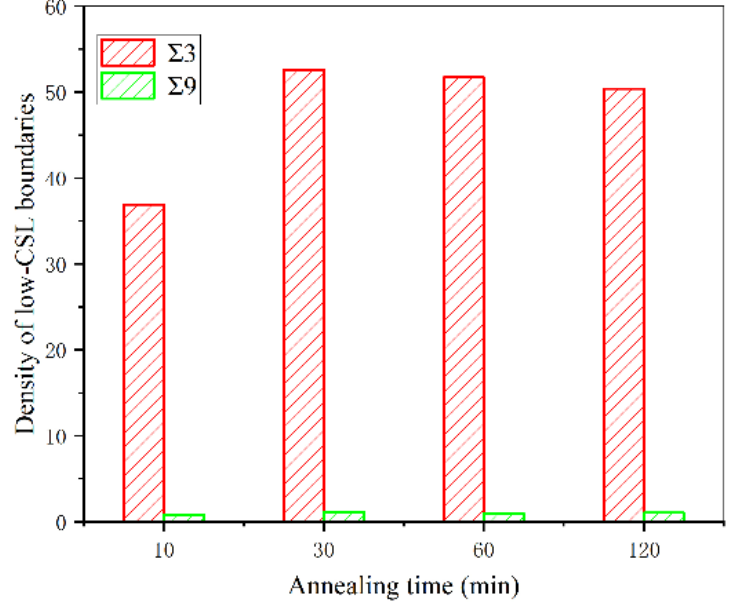
Figure 10. Variations of density of low-CSL boundary with annealing time.